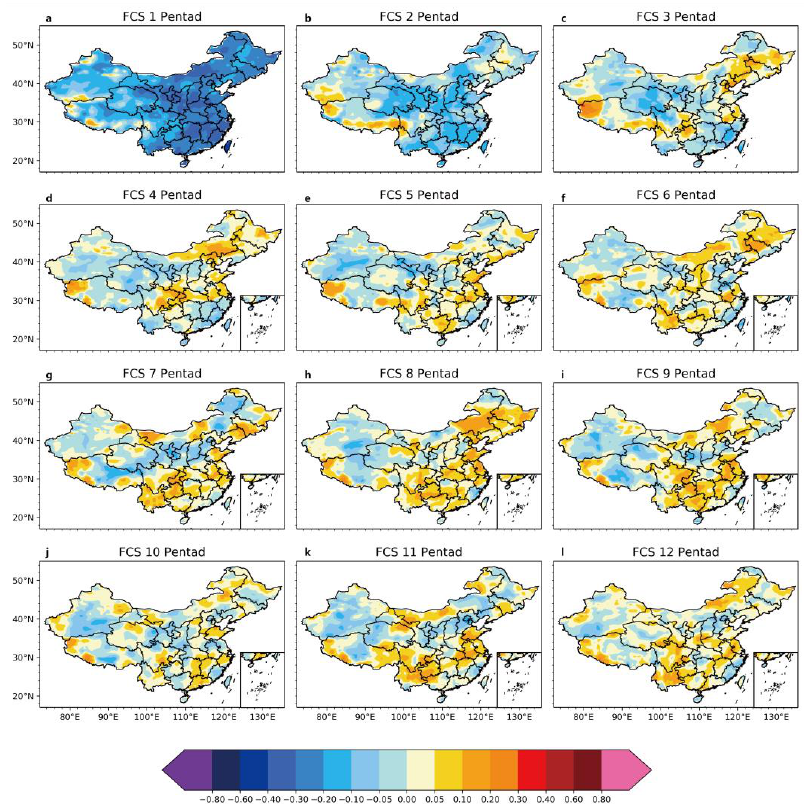
Figure 8. Spatial pattern of the annual average TCC differences (pentad DSDM minus FGOALS-f2) between the pentad DSDM and the FGOALS-f2 model for the 1–12 ( a – l , respectively) pentad precipitation forecast from 2000 to 2018.